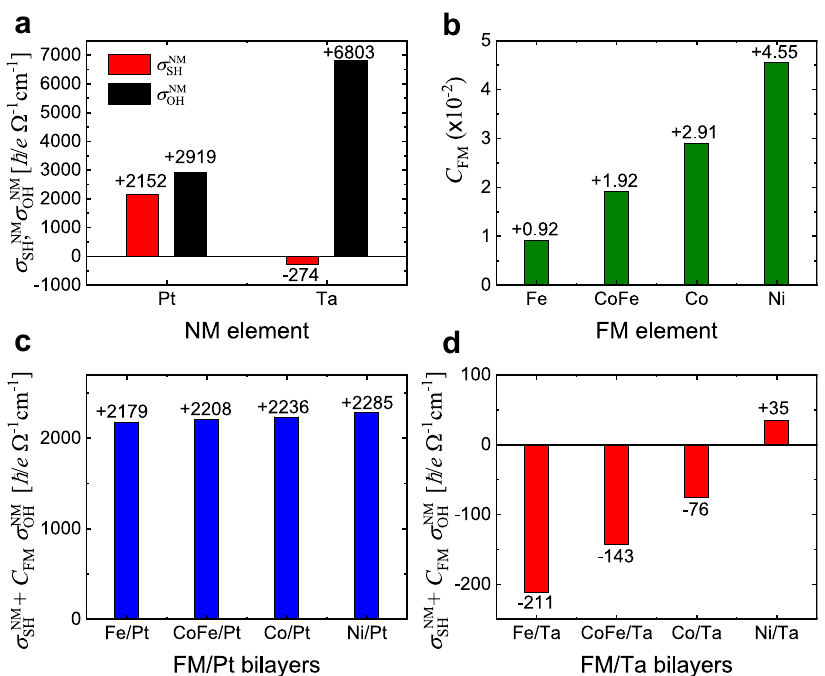
and orbital Hall conductivity σ NM of Pt and β -Ta. b Orbital-to-spin conversion ef fi ciency C FM of Fig. 2 First-principles results. a Spin Hall conductivity σ NM SH OH þ C σ NM þ C σ NM Fe, CoFe, Co, and Ni. c σ NM of FM/Pt bilayers (FM = Fe, Co, CoFe, and Ni). d σ NM of FM/Ta bilayers (FM = Fe, Co, CoFe, and Ni). In FM FM SH OH SH OH ( b ), the value of C FM depends on the ratio T L = T S , where the spin (orbital) transparency T S ( T L ) denotes the likelihood of spin (orbital) Hall current gets transmitted through the FM/NM interface. The ratio T L = T S is assumed to be 0.3 in ( b ), considering that the orbital relaxation is expected to be faster than the spin